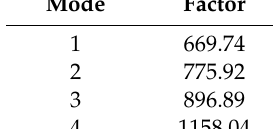
Table 5. Critical load factors.